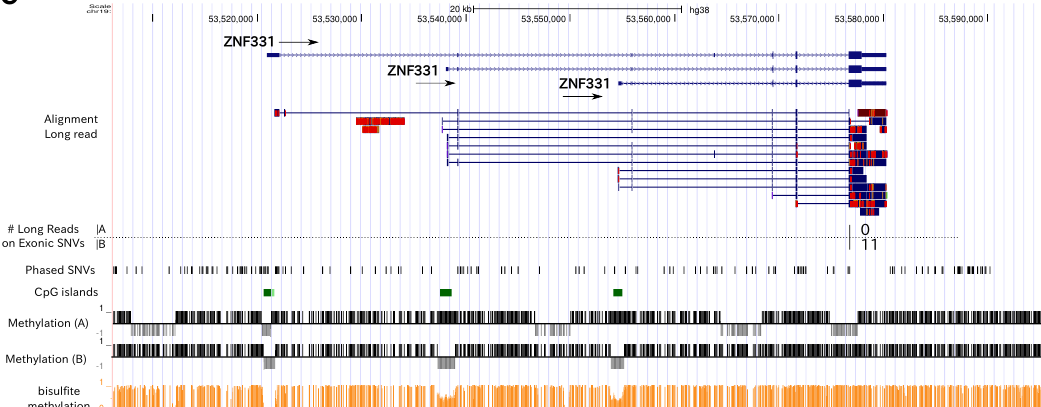
Figure 1. Outline of the proposed method to detect allele-specific methylation (ASM). ( a ) In our method, we assume that haplotype information for the genome is available, i.e., phased heterozygous variants (PHVs) exist (horizontal line in the middle with letters indicating PHVs), which serve as sites of interest (sites shaded in green) for the allele assignment process. Available heterozygous variants found in reads are indicated by letters (A, C, G, or T) at the shaded sites. Other mismatches and insertions/deletions (indels) (shown as letters and yellow blocks) in reads can be assumed to be sequencing errors and therefore ignored. After assigning PacBio reads to either allele (haplotype) by PHVs on the reads, the methylation status of each allele is predicted using (average) kinetics data obtained in the PacBio sequencing process (shaded in blue). Of note, if ASM is not present in the region, wrong assignment of reads does not affect the accuracy of the methylation call; ( b ) Outline of the detection of allele-specific expression (ASE). Only exonic PHVs (two of three in this figure) can be used to distinguish two alleles. Next, ASE can be detected as an imbalance of alleles observed in reads. ( c ) The probability of allele assignment error depends on the number of available PHVs in the reads ( x -axis). The probability was calculated using an equation presented in the text and is shown in logarithmic scale on the y -axis; ( d ) prediction performance (sensitivity and precision) of the method for assessing the perturbed inter-pulse duration (IPD) ratio (purple line). For comparison, typical performance statistics for the original IPD are shown (green line). “ P = 1%” indicates that the IPD was perturbed to simulate 1% read assignment error, as described in the text; ( e ) Example of a region exhibiting ASM in diploid methylomes and transcriptomes. On the right: two CpG islands (CGIs) are shown in the middle; one allele (labeled A) is methylated and the other (B) unmethylated. Each CGI overlaps with the promoter regions of distinct isoforms of a known imprinted gene ZNF331 . Bisulfite sequencing data in the bottom track exhibited intermediate-level methylation for the two CGIs showing ASM. From top to bottom, the panel shows the following features: gene structure, alignments of long RNA-seq (Iso-seq) reads, RNA-seq read counts for two alleles, which indicates ASE, sites of PHVs available in this personal genome (black marks), which were used to determine the allelic origins of the sequencing reads, annotated CGIs (green rectangles), methylation levels of the CpG sites of two alleles that were predicted using single-molecule real-time (SMRT) reads (respective black and gray bars towards positive and negative indicate methylated and unmethylated, respectively), and publicly available data on methylation levels via bisulfite sequencing (orange